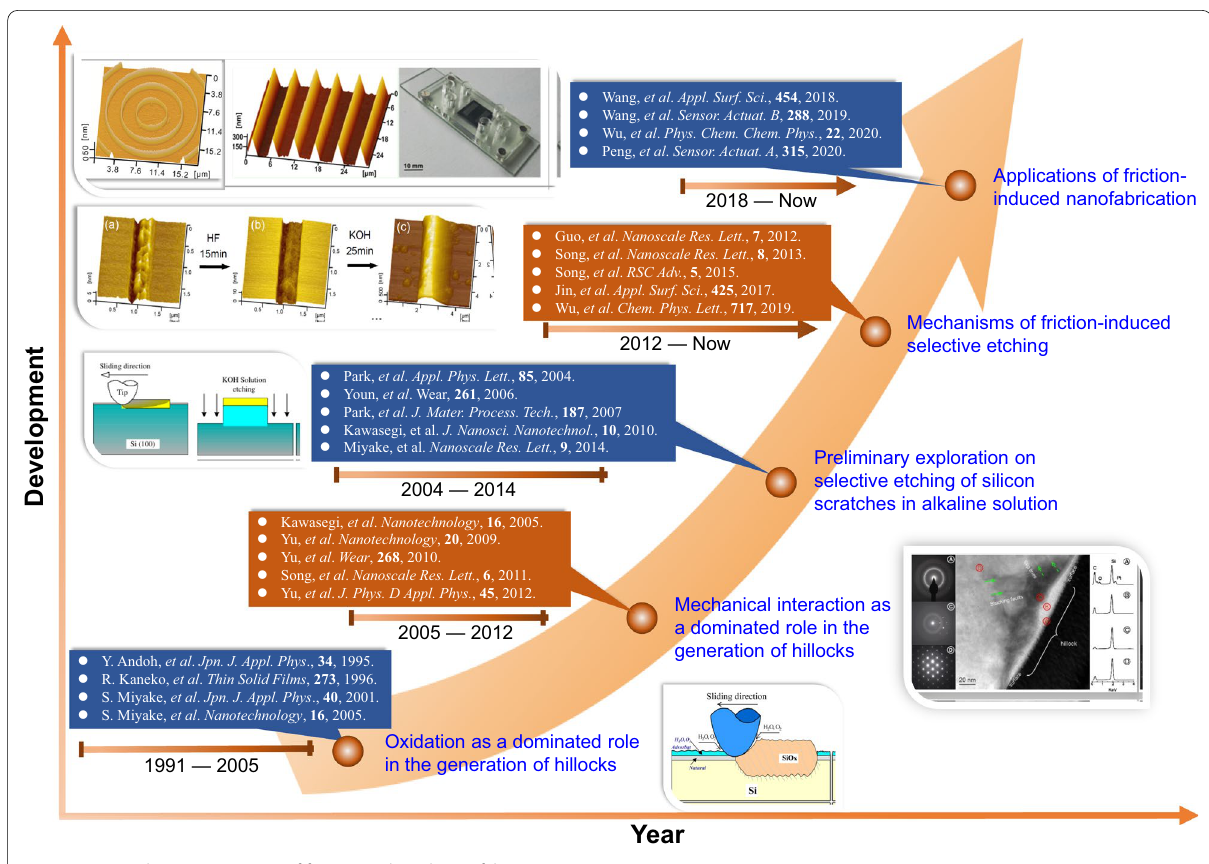
Figure 1 Development process of friction-induced